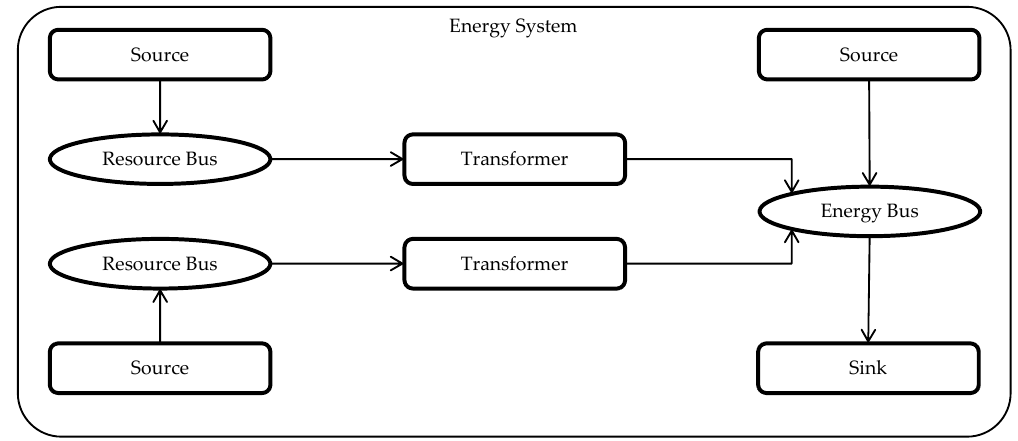
Figure 1. Schematic illustration of an energy system represented as an open-source energy system modelling framework oemof network [27].